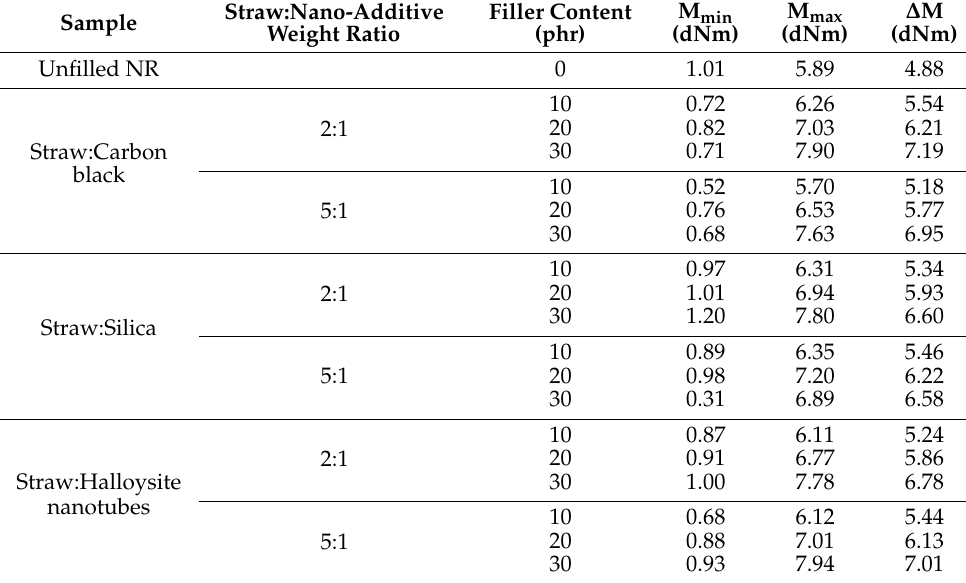
Table 4. The rheometric parameters of the elastomer mixtures.